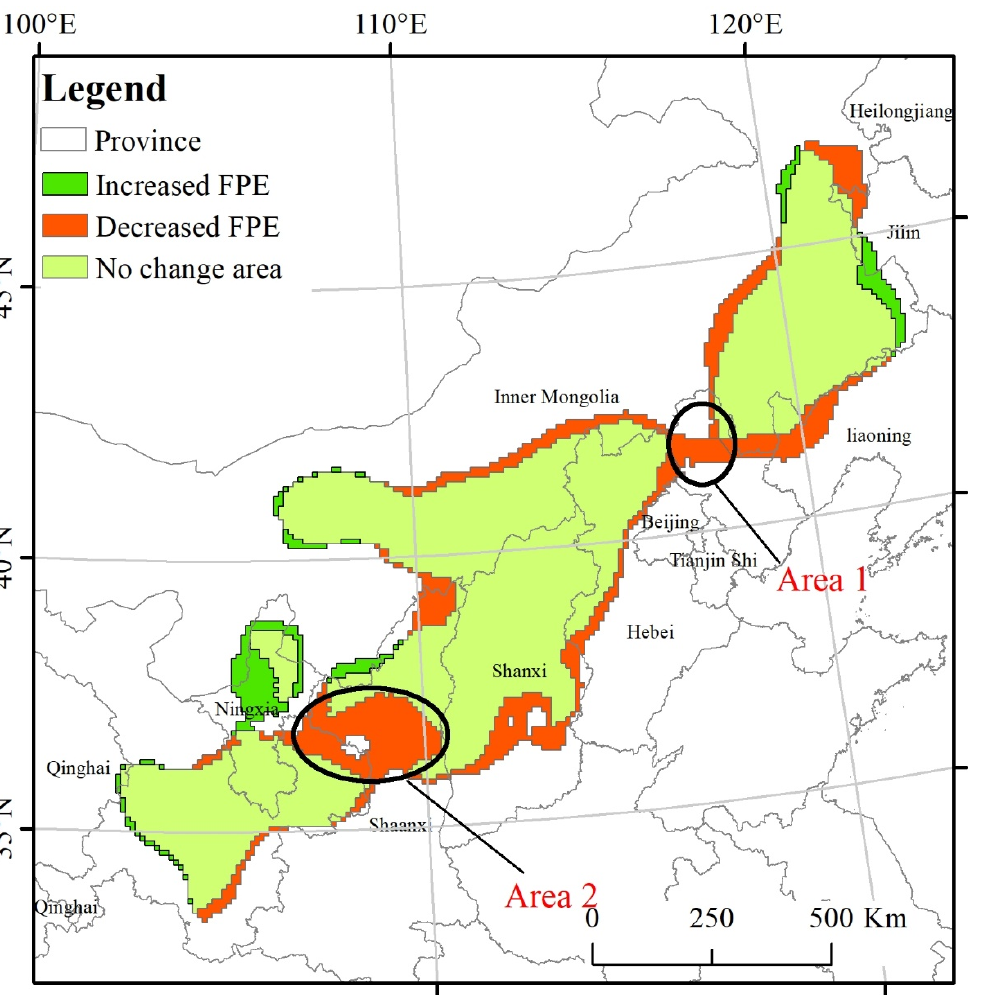
Figure 2. Spatial distribution of increase, decrease, and unchanged regions in FPE from 1985 to